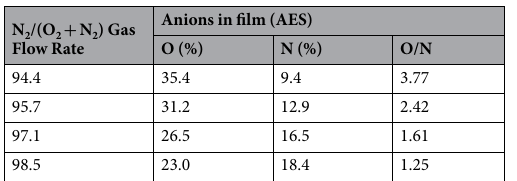
Table 1. Relative oxygen to nitrogen anion ratio in the ZnON films analyzed by Auger electron spectroscopy (AES), with respect to the incorporated nitrogen gas flow rate ratio [N 2 /(O 2 + N 2 )] during growth.